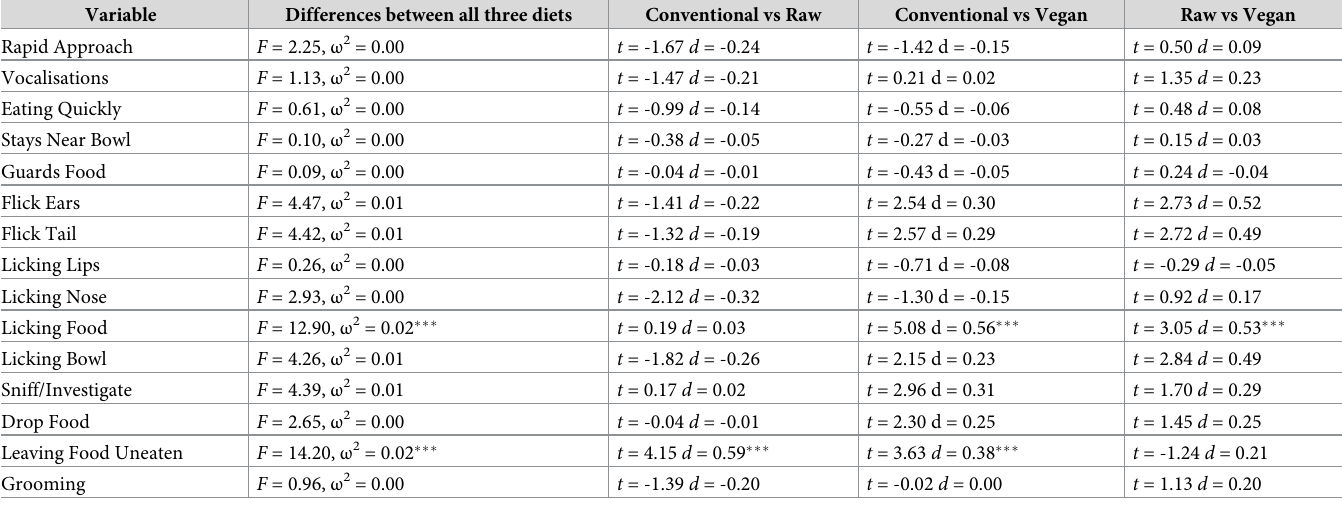
Table 6. Comparison between diet groups for the owner-reported food-oriented behaviour.